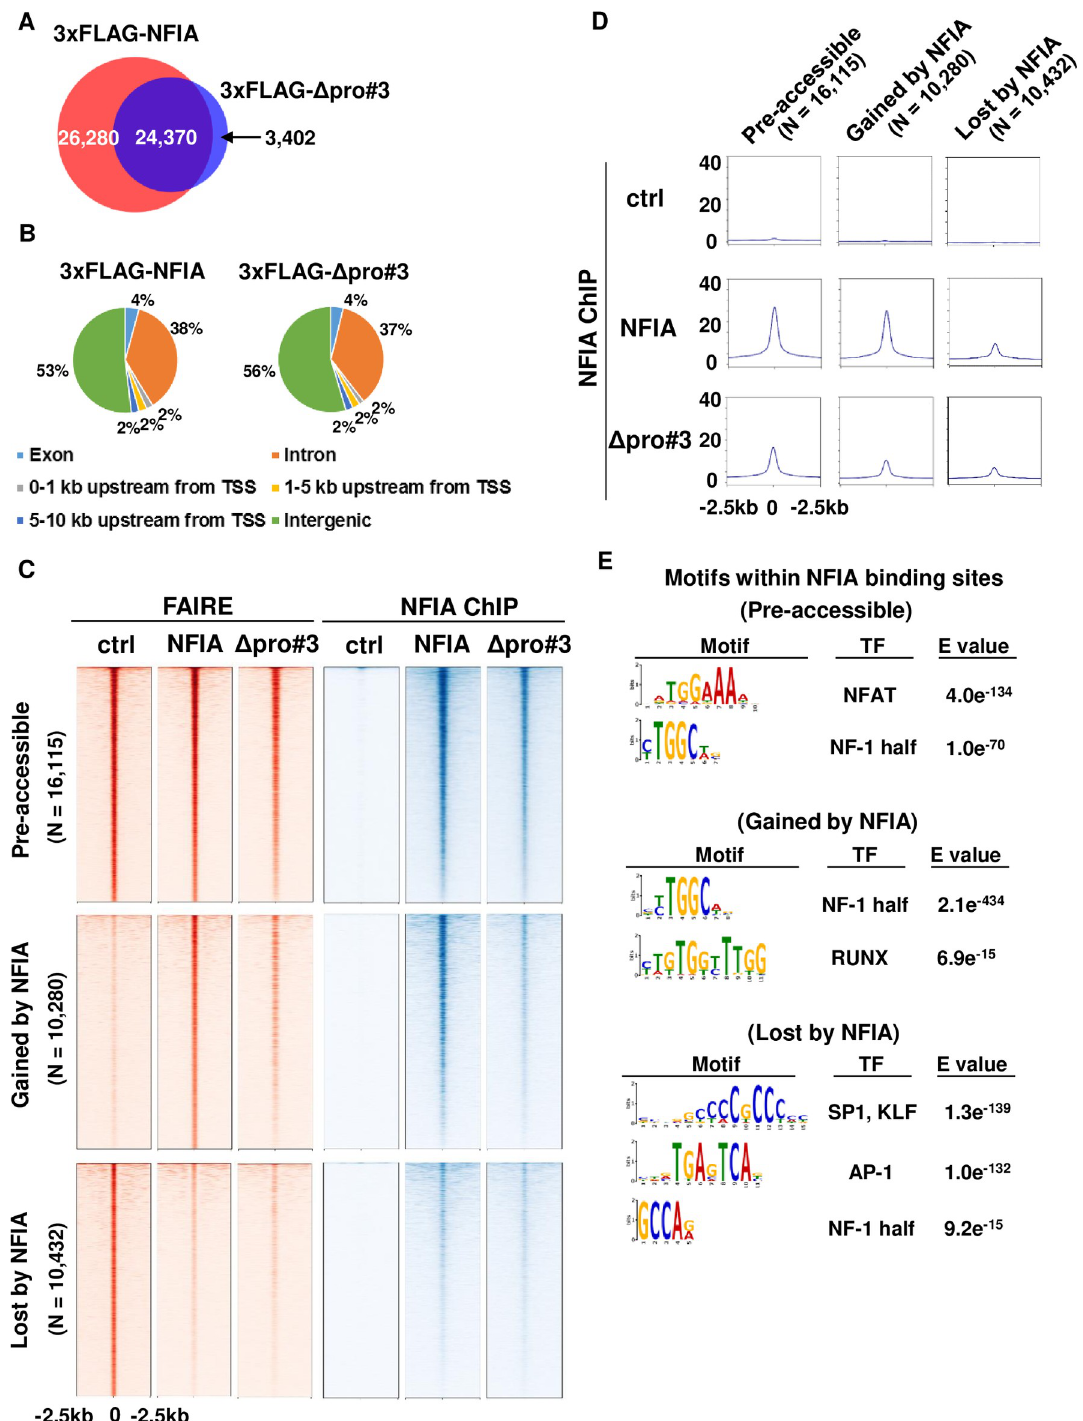
Fig 5. Genome-wide landscape of NFIA binding and changes in chromatin accessibility. (A) Venn diagram showing the overlap of full-length NFIA and Δ pro#3 mutant at day 0 of differentiation. (B) Genomic location of full-length NFIA and Δ pro#3 mutant at day 0 of differentiation. (C) A heat map representation showing tag density signals of FAIRE and NFIA ChIP in indicated cells at pre- accessible chromatin sites in control cells that are still accessible by introduction of full-length NFIA (“Pre-accessible”, N = 16,115), full-length NFIA-dependent accessible chromatin sites (“Gained by NFIA”, N = 10,280) and full-length NFIA-dependent inaccessible chromatin sites (“Lost by NFIA”, N = 10,432). (D) An aggregate plot showing tag density signal of NFIA ChIP at the regions shown in (C). (E). De novo motif analysis of NFIA binding regions in indicated